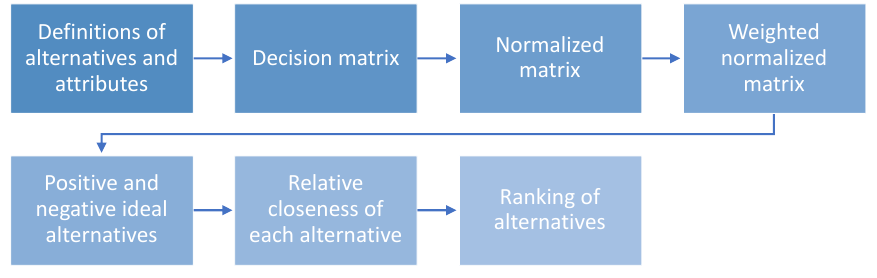
Figure 8. TOPSIS method flowchart.